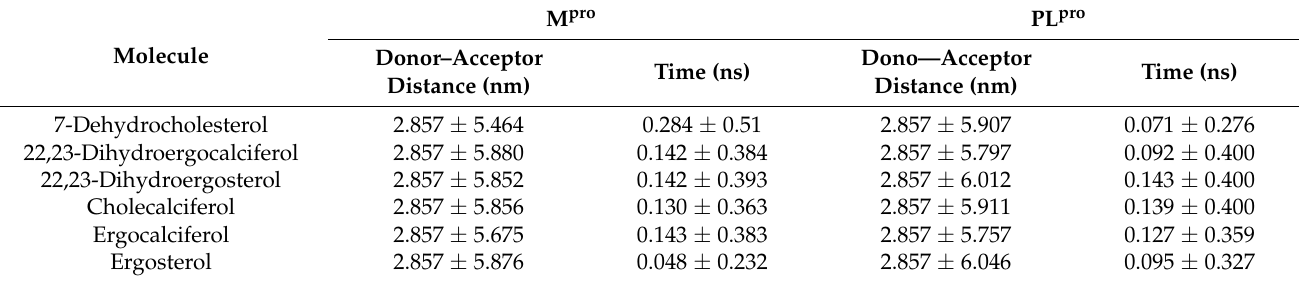
Table 8. Hydrogen bond distribution for Mpro and PLpro ligand